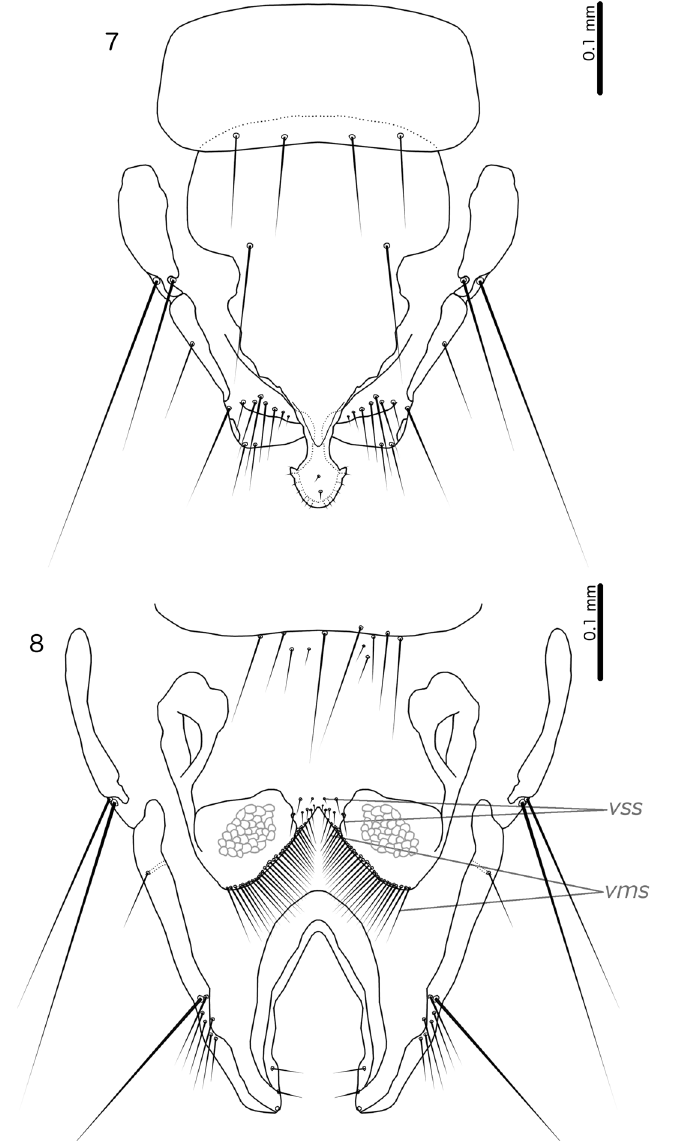
(NHMUK010682393). 7 . Male subgenital plate and terminal end of abdomen, ventral view. 8 . Female subgenital plate and terminal end of abdomen, ventral view. Abbreviations: vms = vulval marginal setae; vss = vulval submarginal